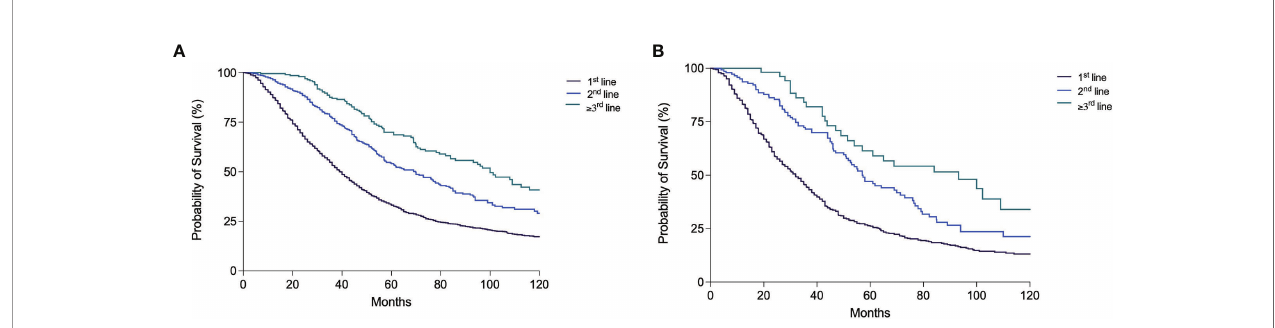
FIGURE 5 | Kaplan – Meier curves showing overall survival according to the line (1st, 2nd, ≥ 3rd) of TACE treatment during the patient clinical history in the overall patient population (A) and in BCLC B patients (B) (both p <